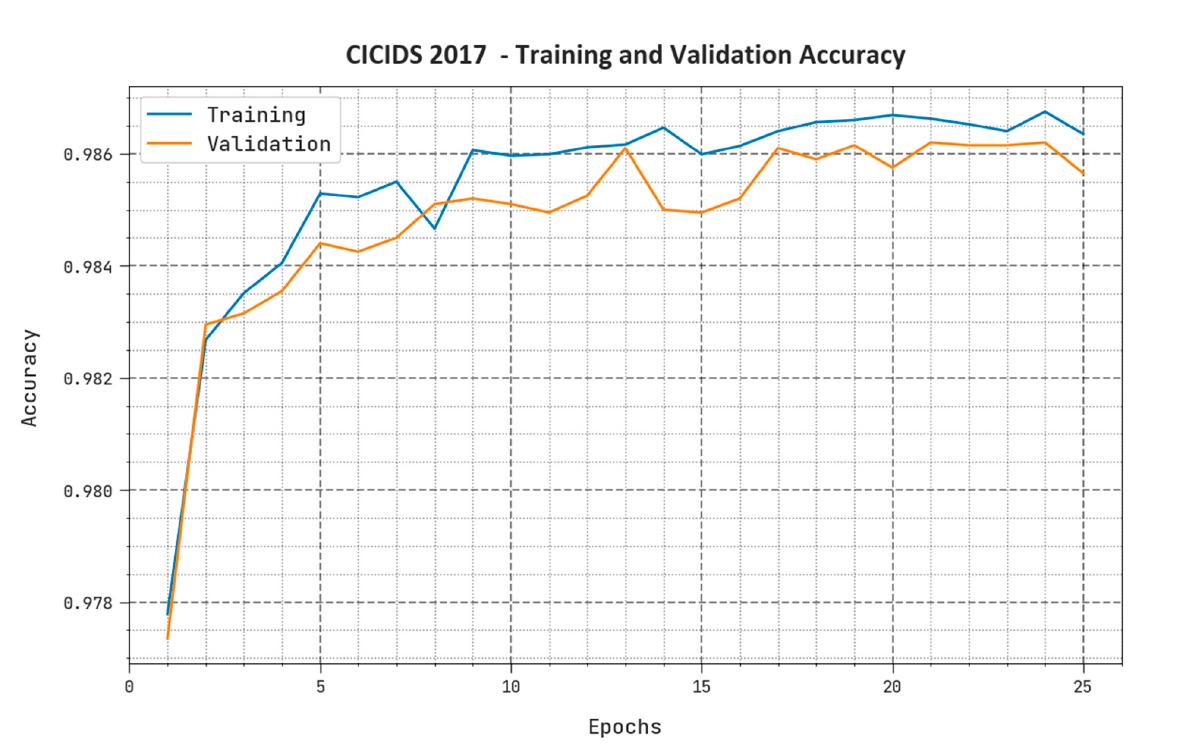
Figure 7. TACY and VACY outcome of XAIID-SCPS system on CICIDS 2017 dataset.